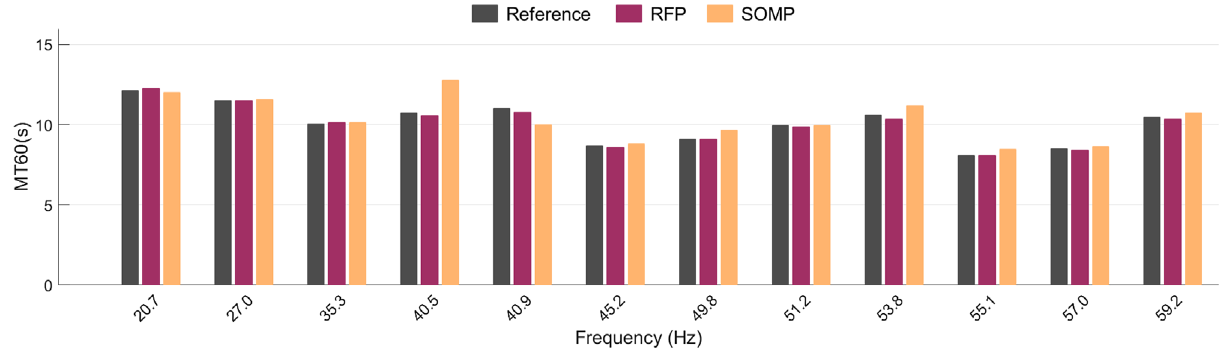
Figure 3. Modal decay times for the eigenfrequencies of the non-rectangular reverberant room as estimated by the SOMP and RFP methods, in comparison with the FEM analysis